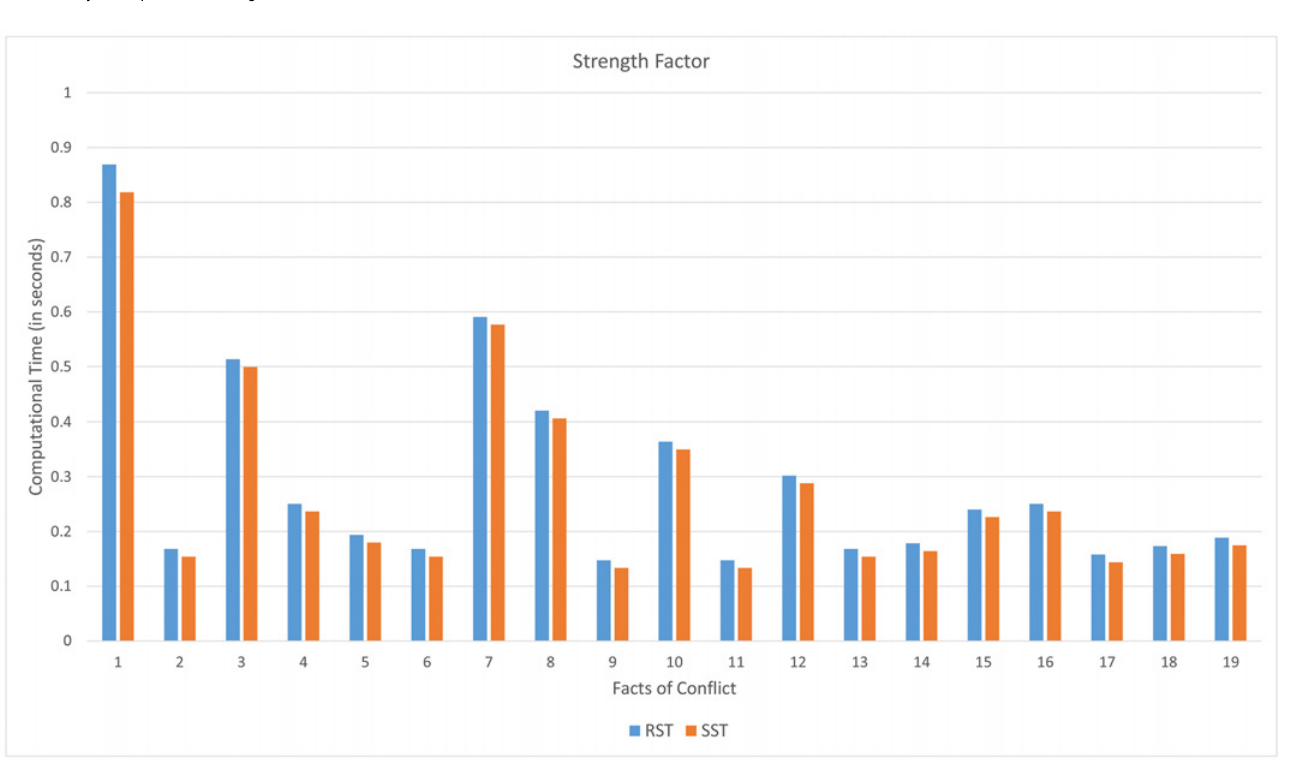
Fig 13. Computational time on computing